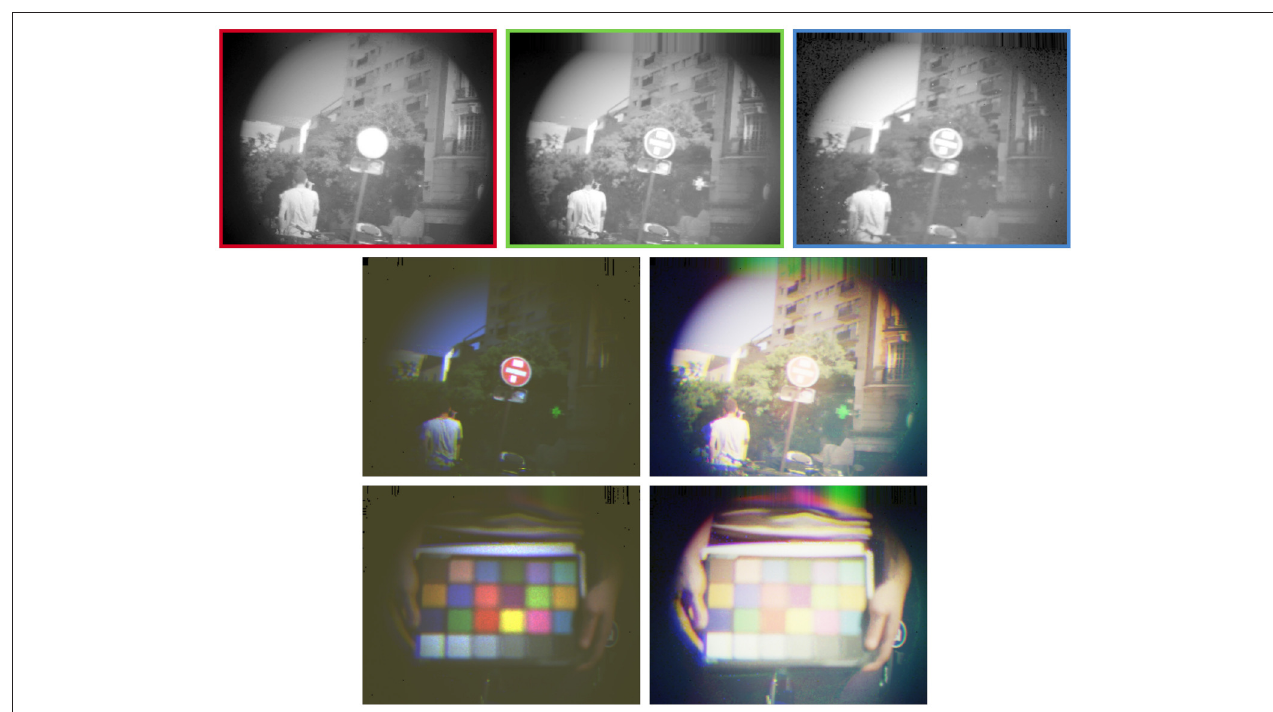
FIGURE 8 | The figure’s top row shows reconstructed frames from events acquired by each sensor of the three-chip event-based camera. The gray levels are tone-mapped with a logarithmic function in order to be displayed on a regular screen. The bottom-left frames are reconstructed with the linear color model presented in the methodology. The colors are properly reconstructed, but very little detail is left in dark areas. The bottom-right frames use the channels’ logarithmic tone-mappings as their color channel, yielding incorrect colors but much more details in dark